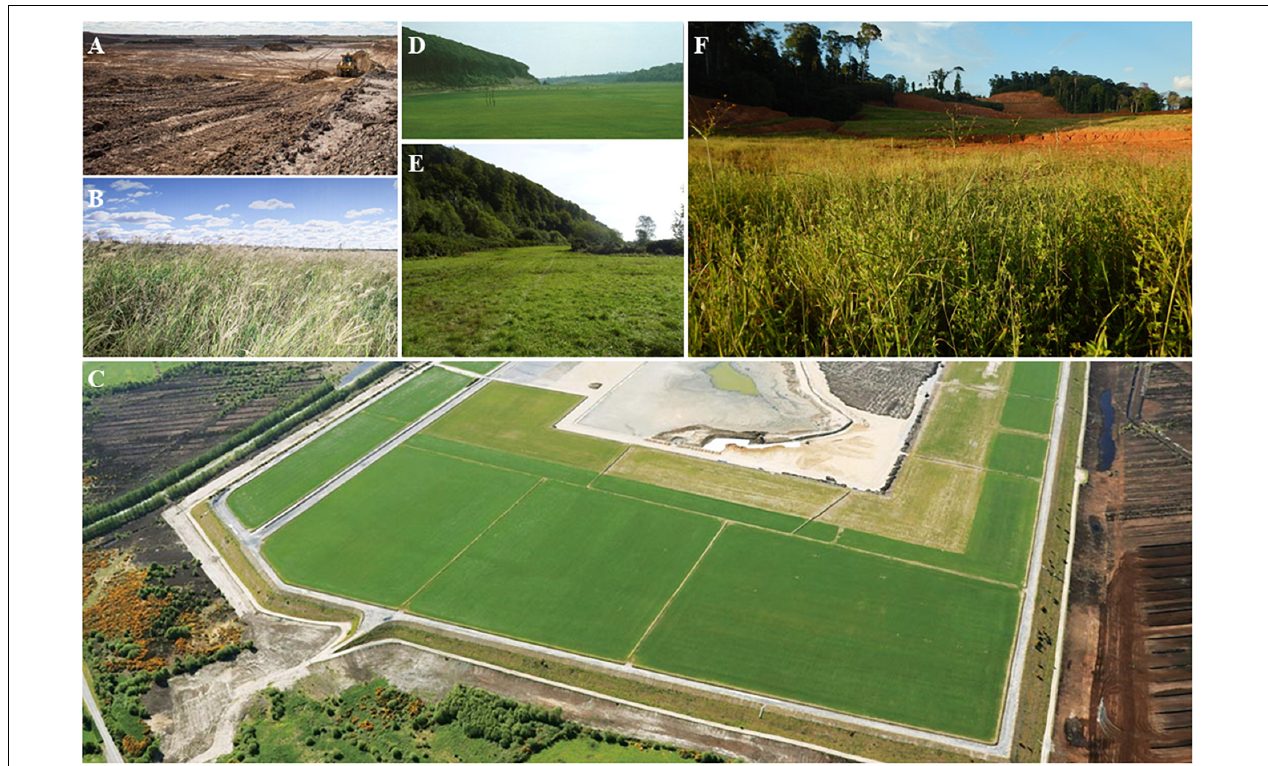
FIGURE 6 | Rehabilitation of mining areas in Australia (A,B) , Ireland (C–E) , and Guyana (F) by using grasses (grass species not specified). A: Commodore Coal Mine before rehabilitation (Minerals Council of Australia [MCA], 2016); B: Commodore Coal Mine after rehabilitation (Minerals Council of Australia [MCA], 2016); C: Tailings management facility rehabilitation at Lisheen Mine (Courtney, 2018); D: Shelton Abbey rehabilitated tailings site after shortly seeding in 1982 (Courtney, 2018); E: Shelton Abbey rehabilitated tailings site after seeding in September 2016 (Courtney, 2018); F: Rehabilitation of mining sites located in the heart of the Amazon rainforest